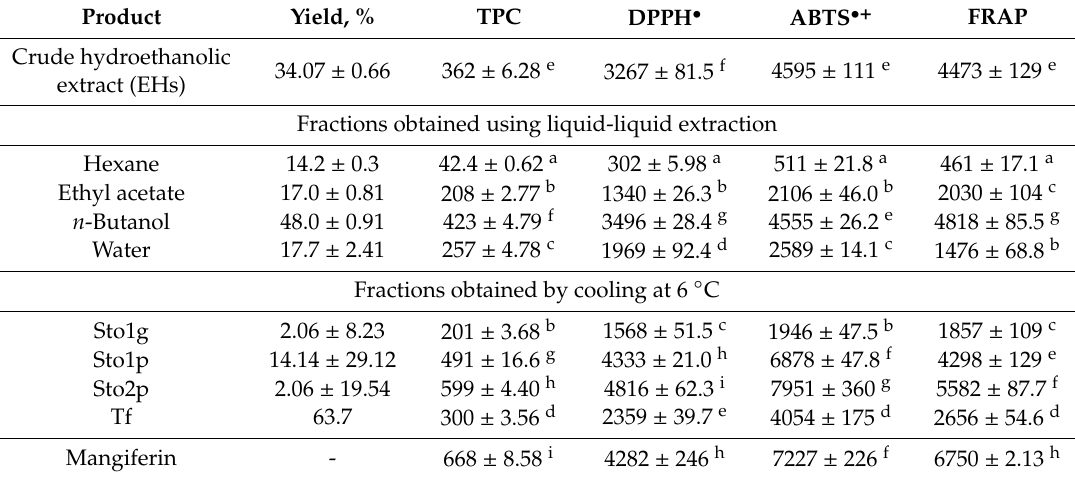
Table 2. Yield, total phenolic content (TPC) (in mg GAE / g DWE or DWF), and antioxidant capacity (in µ M TE / g DWE or DWF) of crude hydroethanolic extract and its fractions. Product Yield,